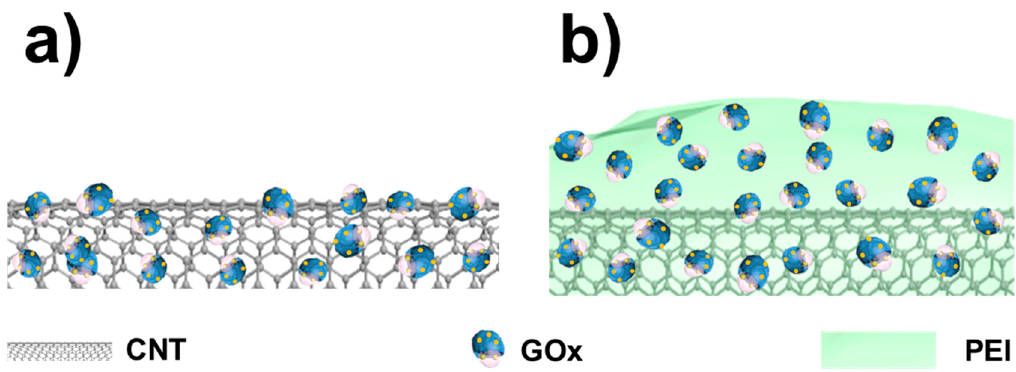
Figure 1. Structure of ( a ) carbon nanotube (CNT)/ glucose oxidase (GOx) and ( b ) CNT/PEI (polyethyleneimine)/GOx catalyst.